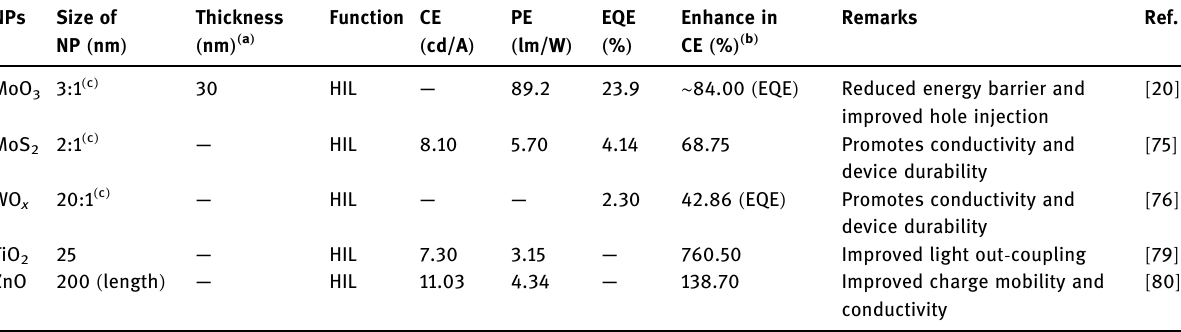
Table 2: Device characteristics of OLEDs with inorganic NPs - doped PEDOT:PSS NPs Size of